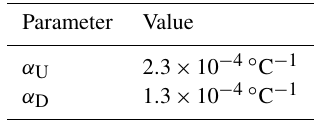
Table 4. Thermal expansion coefficients.